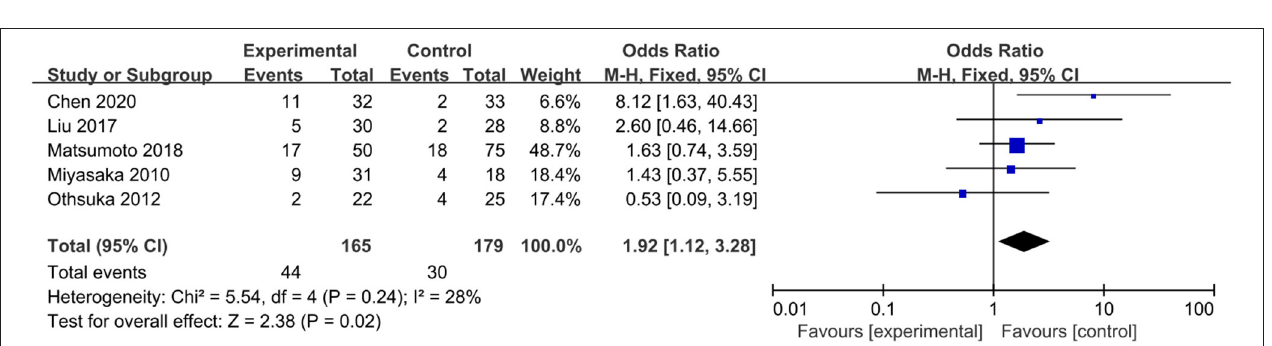
FIGURE 2 | Forest plot of air leak rate comparing using electrocautery to stapler.